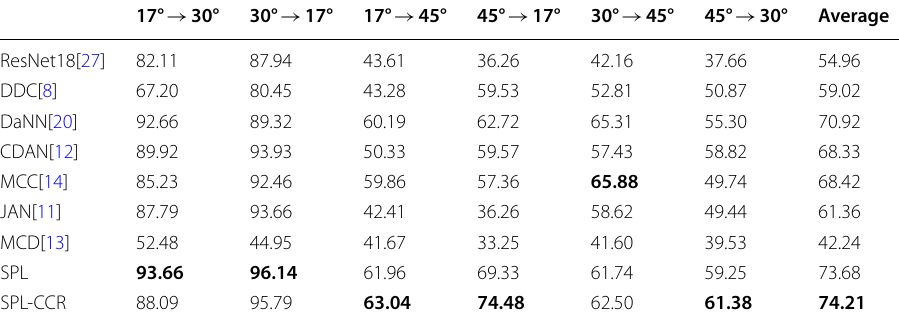
Table 5 Classification results of different methods with 10 samples randomly selected for each class 17° →